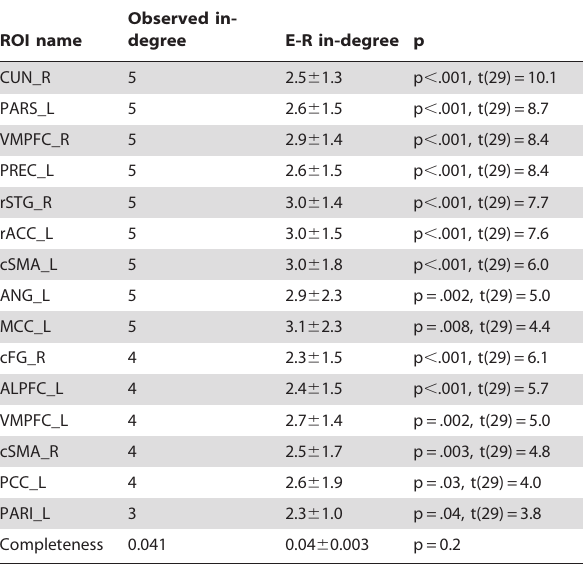
Table 4. Brain regions with indegree higher than random